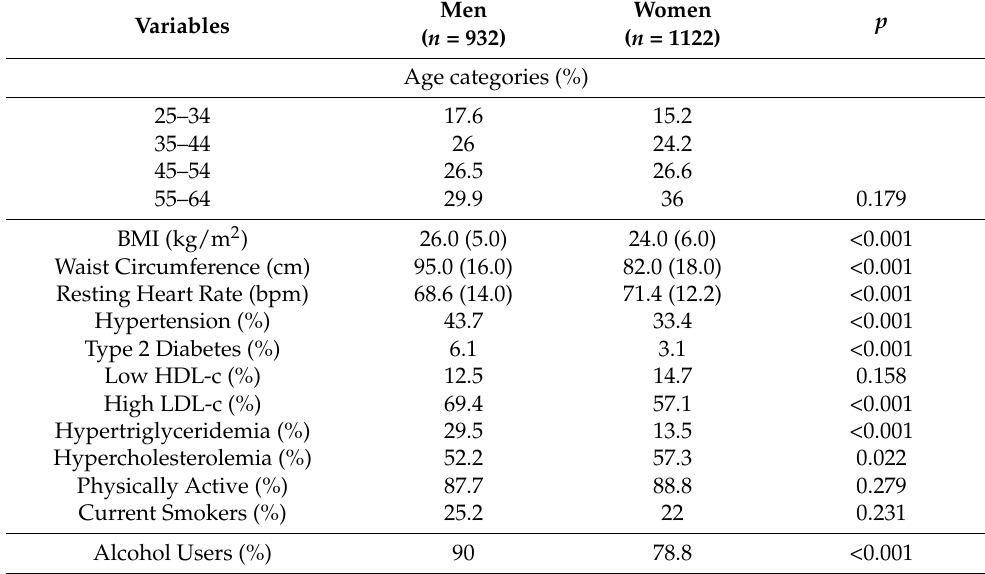
Figure 1. Flowchart of the recruitment, baseline data collection, and selection of the participants for the analysis. Table 1. Characteristics of the subjects ( n = 2054).